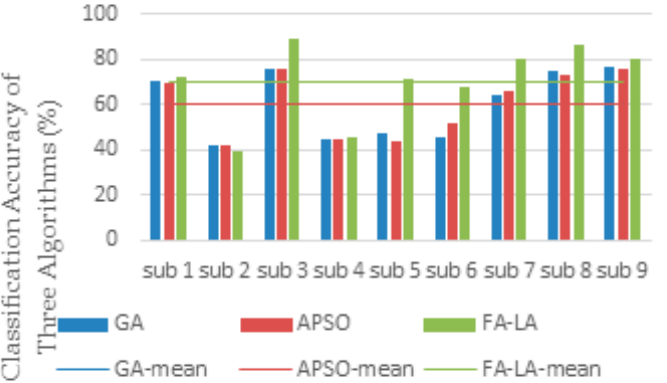
Figure 8. Classification accuracy of the three algorithms: GA, APSO, and FA-LA, for data set 2a from